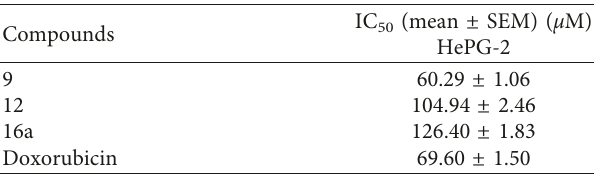
Table 2: IC 50 of highly cytotoxic active derivatives against human cancer cell lines.